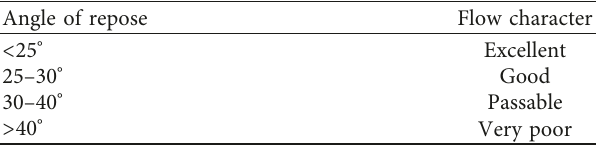
Table 2: Effect of angle of repose on flow character.